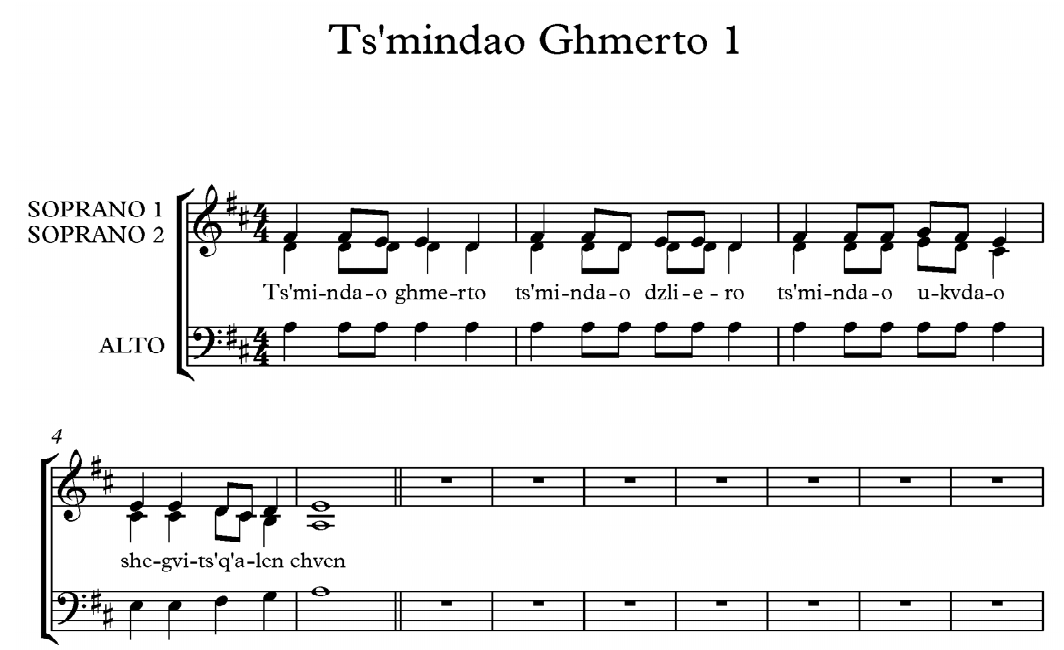
Figure 6. Funeral Trisagion; ornamented mode; Upper Svan variant.